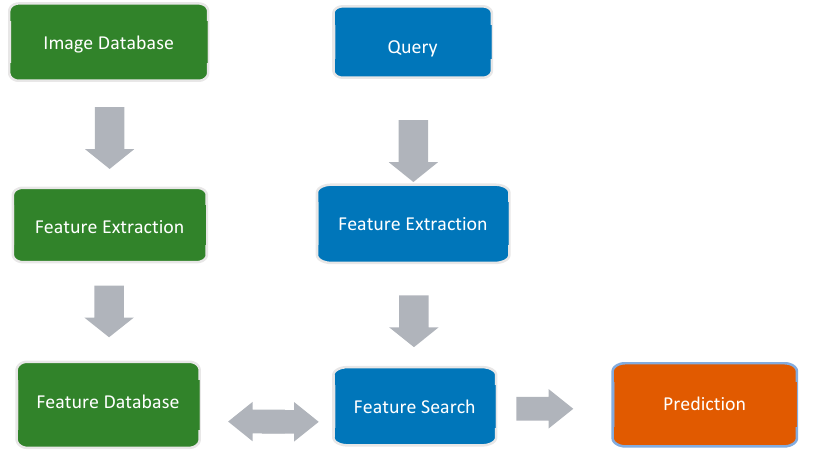
Figure 2. The flow diagram on the use of VLAD.